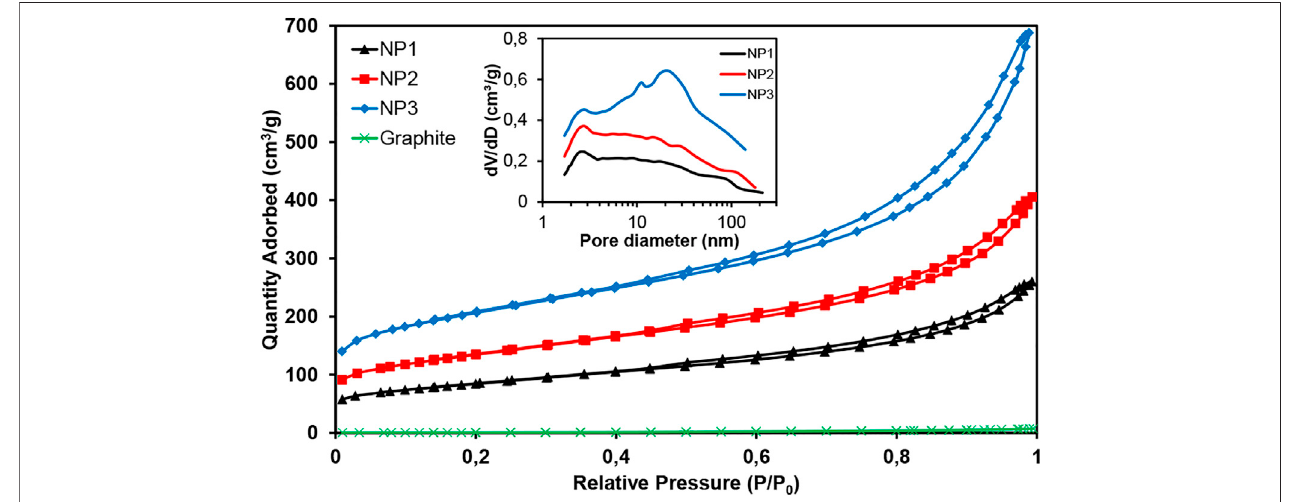
FIGURE 2 | Nitrogen adsorption – desorption isotherms of graphite and three GNPs studied. Inset: pore size distribution for GNPs.